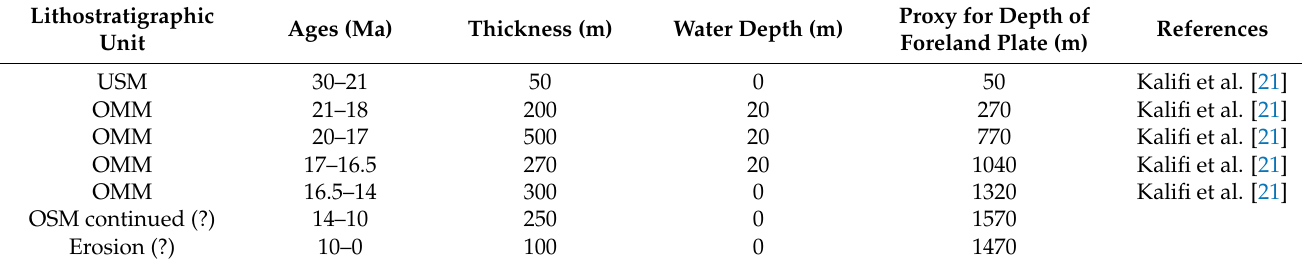
Table 1. Source information that was used to calculate the subsidence pattern of the foreland plate underlying the Western (French) part of the Molasse basin NE of Chambery (site labelled as F in Figure 2). USM = Lower Freshwater Molasse, OMM = Upper Marine Molasse, OSM = Upper Freshwater Molasse; these are the commonly used German abbreviations for the Molasse